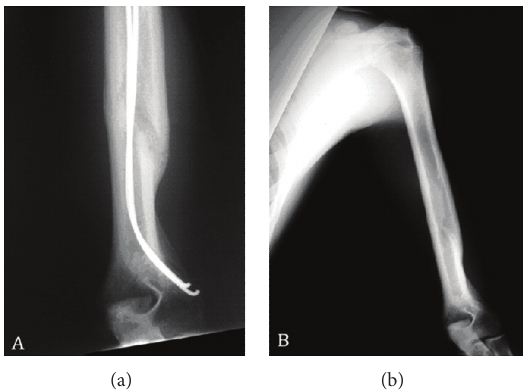
Figure 3: (a) External rotation radiograph showing abundant callous formation, maintenance of fracture alignment, and position of nonlockedflexibleintramedullarynails.(b)Externalrotationradiographoneyearaftersurgeryillustratingremovaloftheimplant,remodeling of fracture alignment, and excellent alignment of the humeral shaft.